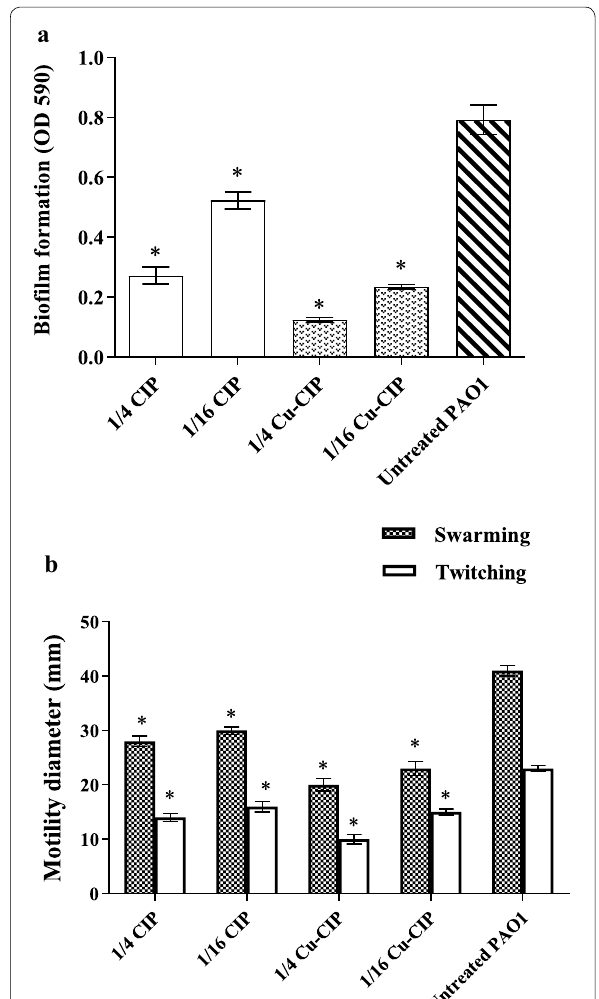
Fig. 4 Effect of subinhibitory concentrations (1/4 and 1/16 MIC) of ciprofloxacin (CIP) and copper-ciprofloxacin complex (Cu-CIP) on a biofilm formation and b swarming ■ and twitching □ motilities (*, significant, P <